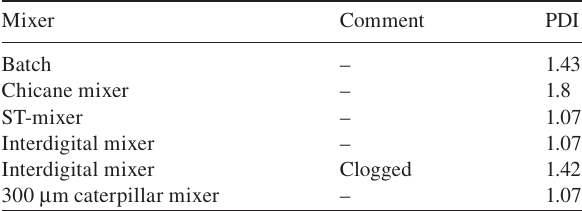
Table 4 PDIs for different micromixers and process